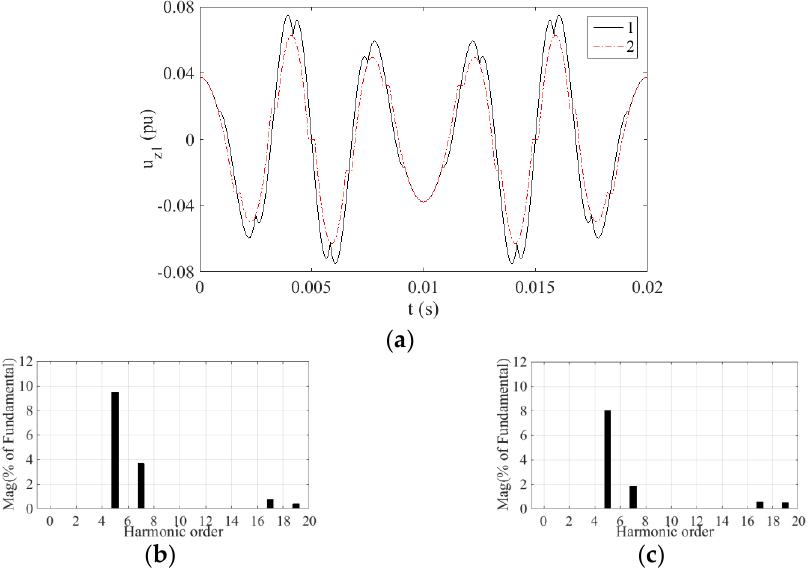
Figure 9. Simulation results u z1 of two strategies at m = 0.615. Here, 1 denotes the TFOS strategy, 2 denotes the proposed HSOS strategy: ( a ) u z1 waveforms of the two strategies; ( b ) Spectrum analysis of the TFOS; ( c ) Spectrum analysis of the proposed HSOS.